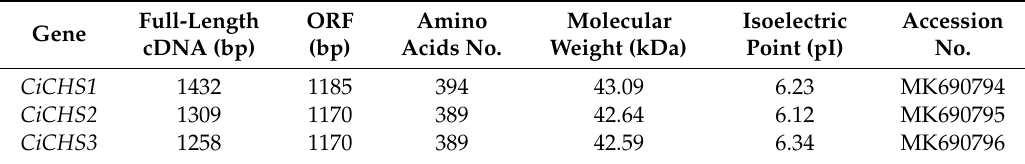
Table 1. Information regarding 3 CiCHSs